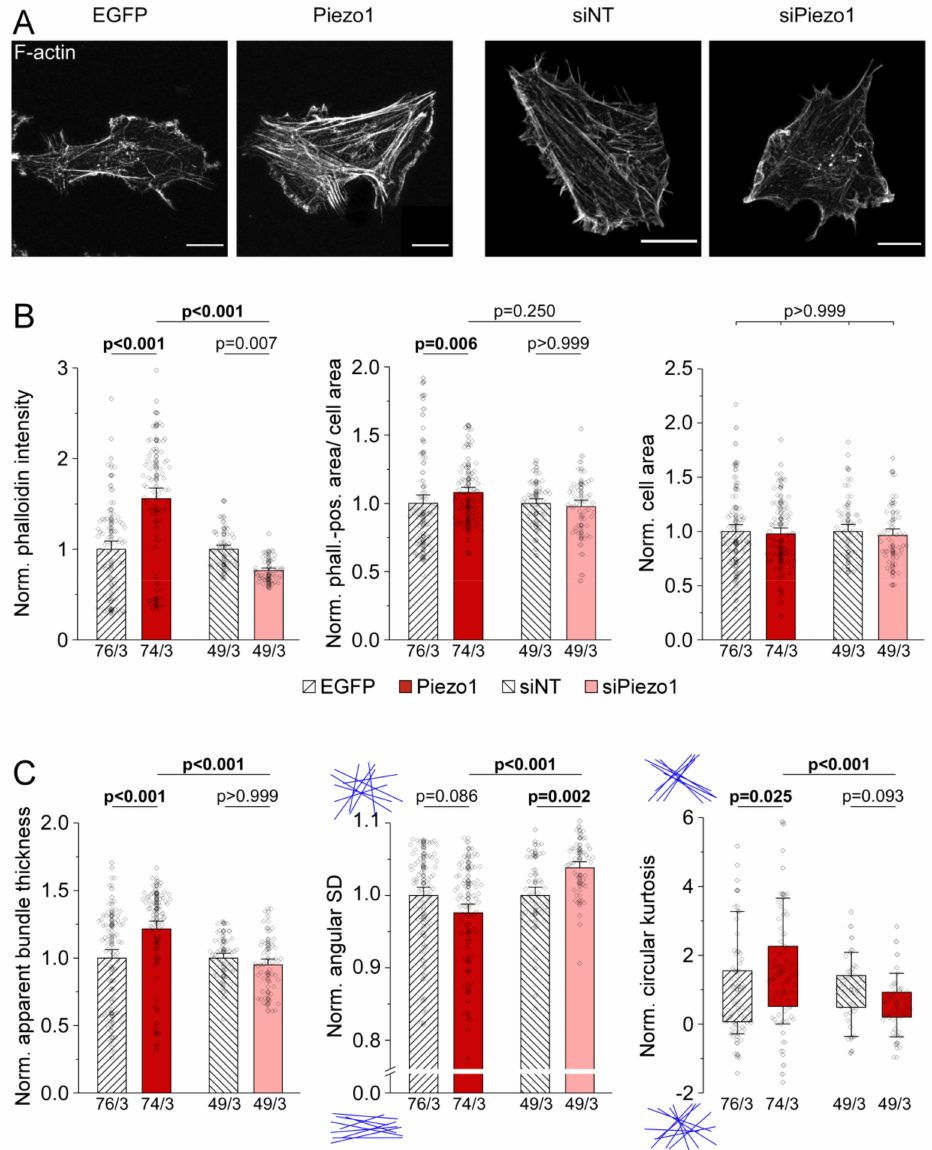
Figure 5. Piezo1-dependent alterations of HAF stiffness are a result of differential organization of the actin cytoskeleton. ( A ) representative images of the actin cytoskeleton of HAF 3 days post- transfection, stained by phalloidin. Scale bars = 20 µ m. ( B ) average phalloidin intensity, phalloidin- positive area per cell area, and cell area. ( C ) apparent thickness, angular standard deviation (SD), and circular kurtosis of actin bundles. All data normalized to the mean of the respective control. See Figure S3 for raw data. n/N = number of cells/number of